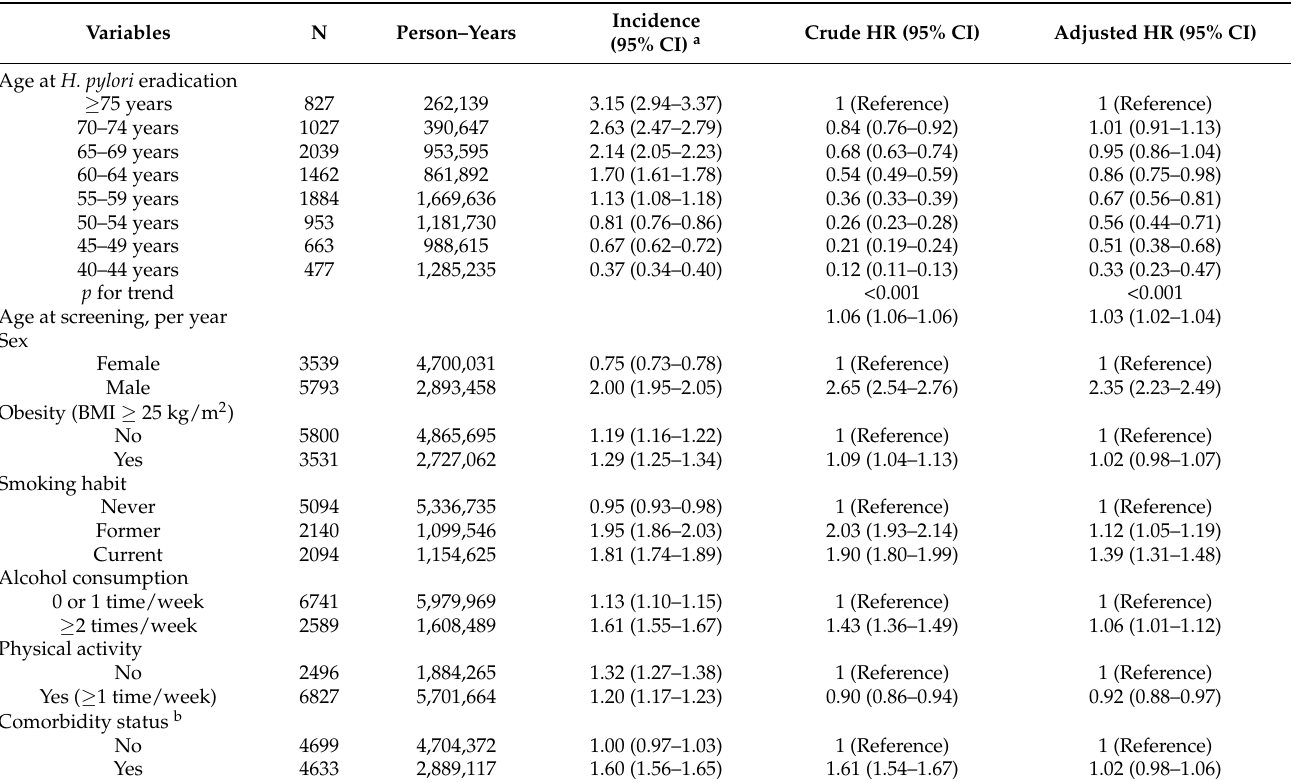
Table 3. Risk of gastric cancer according to age at H. pylori eradication in patients without a family history of gastric